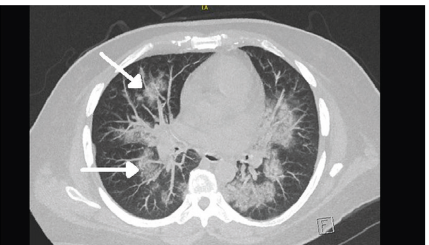
Figure 5: Predominantly central patchy and confluent ground- glass and interstitial opacities (arrows). This pattern is nonspecific but, given the patient’s history, is favored to represent alveolar hemorrhage secondary to vasculitis.